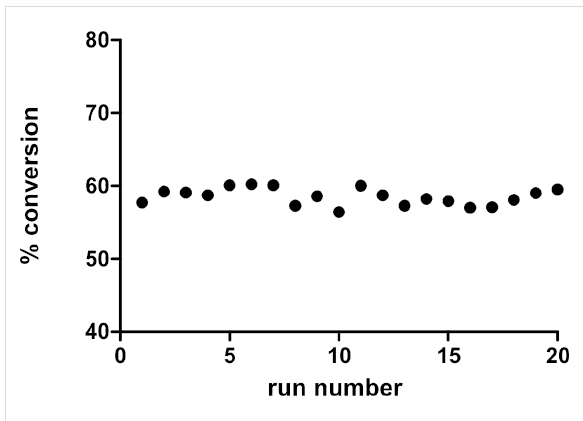
Figure 4: Conversion of styrene to ethylbenzene over 20 reactions in sequence through a single 30 mm 10% Pd/C CatCart ® . All reactions were carried out with a 10% Pd/C 30 mm CatCart ® , with 2.0 M in MeOH, at a flow rate of 1.0 mL/min, at 30 °C, with 1.9 mL per injection, and 10 mL product solution collected. The conversion was determined by GC–MS analysis with decane as an internal standard.